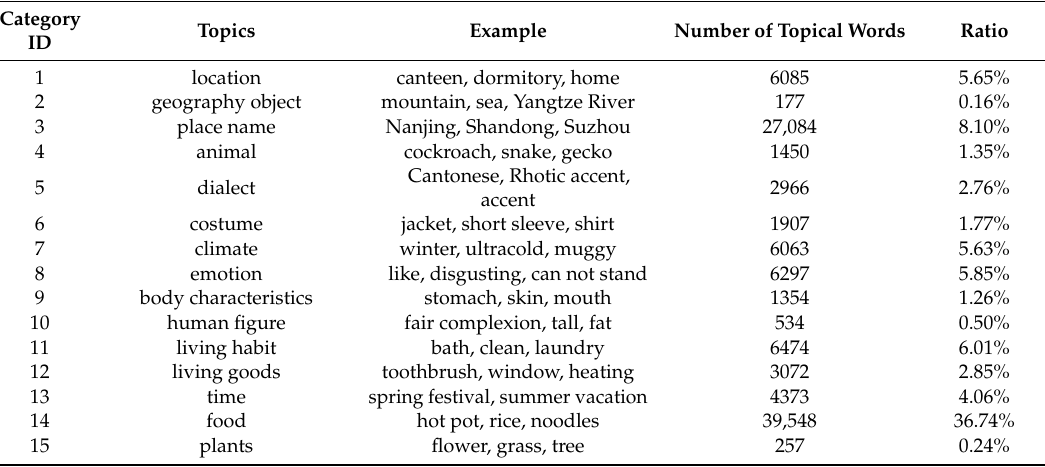
Table 3. Topic cluster and